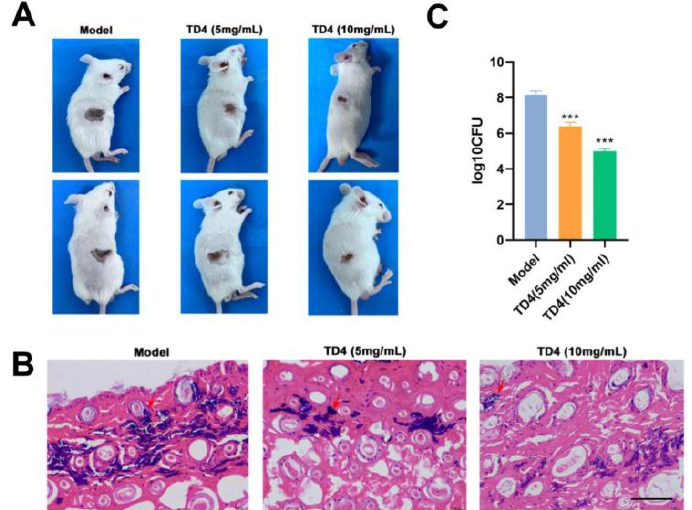
Figure 5. Therapeutic efficiency of TD4 on MRSA-induced skin infections in BALB/c mice. ( A ) The size of infected lesions in mice in the model control group, 5 mg/mL, and 10 mg/mL TD4 groups. ( B ) Skin pathological observation of model control group and intraperitoneal injection of 5 mg/mL and 10 mg/mL TD4 group. Scale bar = 100 µm. ( C ) Analysis of colony-forming units of MRSA USA 300 in infected tissues of mice, *** p < 0.001, n = 3.